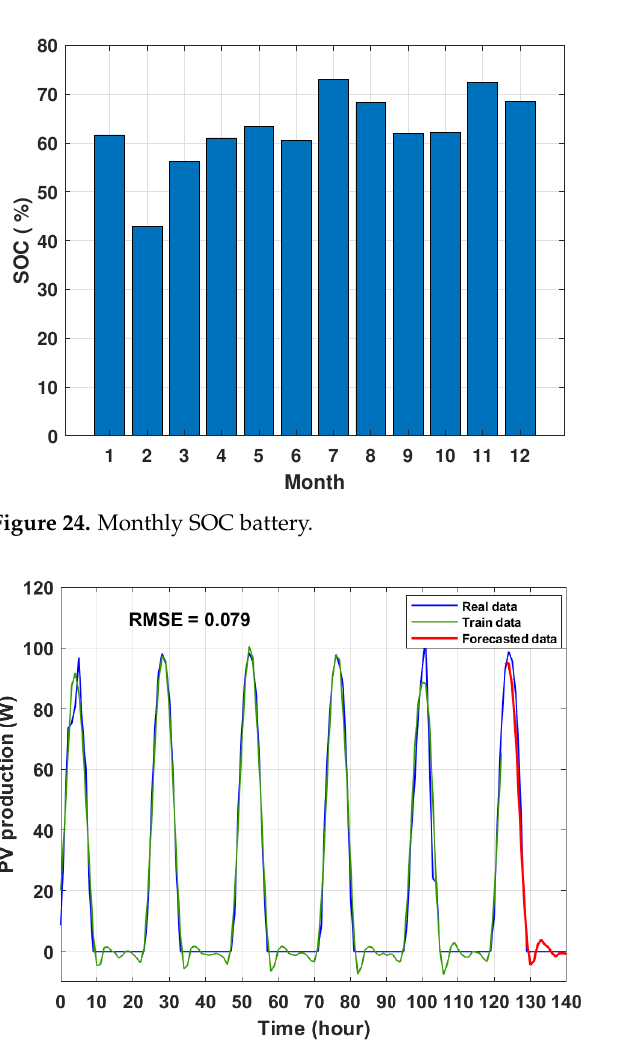
Figure 25. Hourly PV panel power